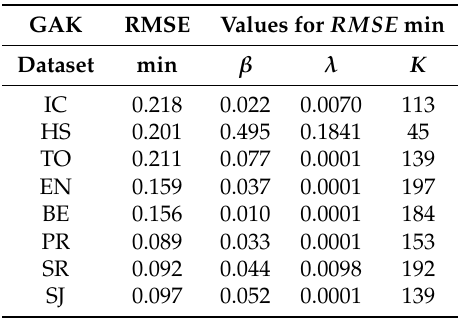
Table 3. Results for the optimization method